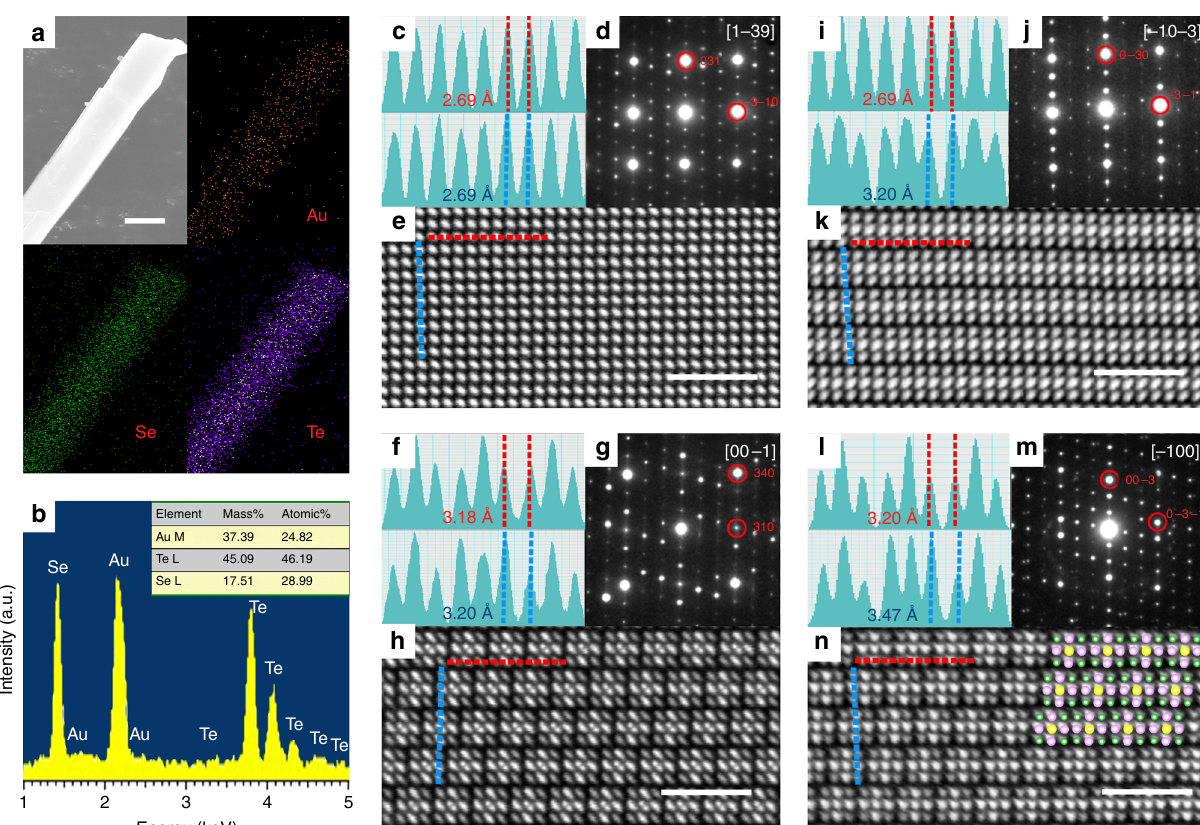
Fig. 1 Compositional mapping and HAADF images of AuTe 2 Se 4/3 . a The SEM image of AuTe 2 Se 4/3 and the EDS mapping images of Au (golden), Se (green), and Te (violet) in AuTe 2 Se 4/3 . The scale bar here represents 2 μ m. b The elemental ratio of Au, Te, and Se obtained from the EDS mapping. The two kinds of atomic distances (red and blue color) are estimated along c [1 – 39], f [00 – 1], i [ − 10 − 3], and l [ − 100] zone axes, respectively. The SAED images are taken along d [1 – 39], g [00 – 1], j [ − 10 − 3], and m [ − 100] zone axes, respectively. The HAADF images show atomic distributions of Au, Te, and Se along e [1 – 39], h [00 – 1], k [ − 10 − 3], and n [ − 100] zone axes in real space, respectively. The scale bars here represent 2 nm. The Au, Te, and Se atoms are superimposed on the spots in n , as the structural analyses (see the